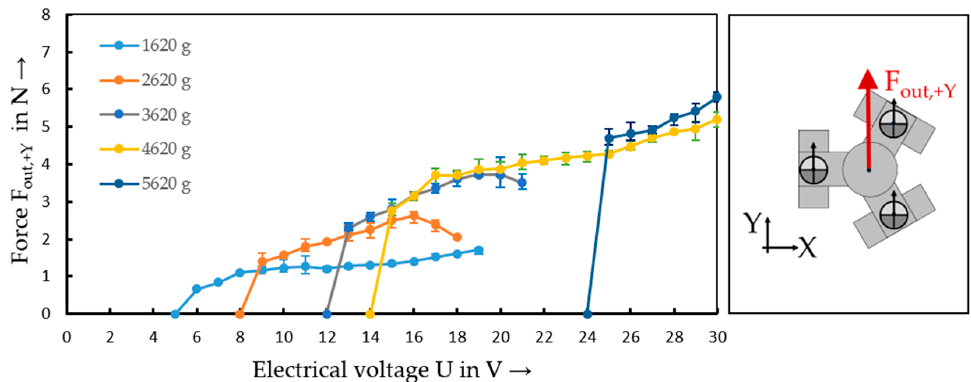
Figure 13. Measurement results of output force F out,+Y of the planar motor platform. Table 5. Appropriate operating ranges for force in the +Y direction.